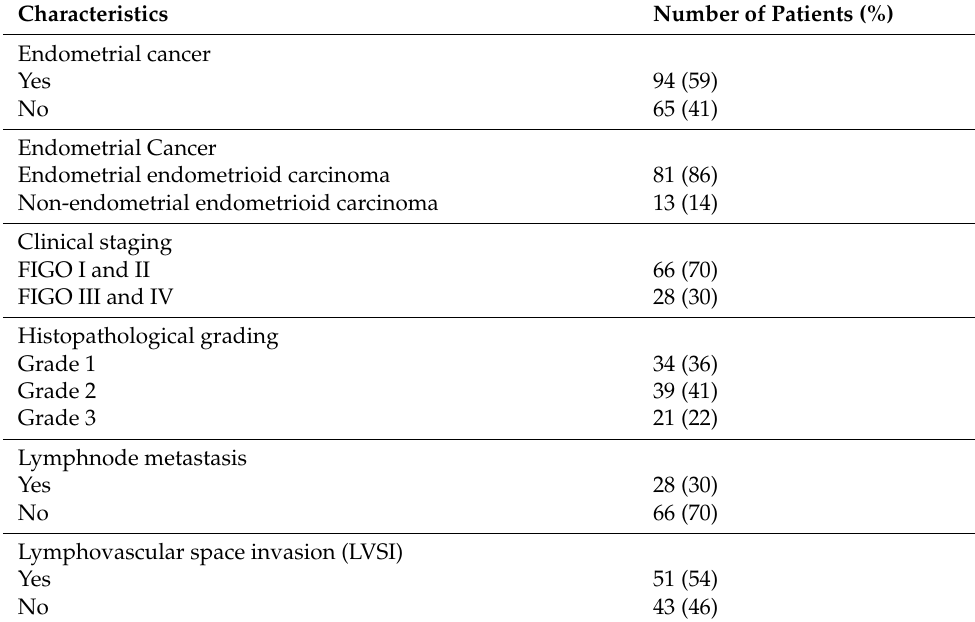
Table 1. Characteristics of patients including endometrial cancer characteristics.